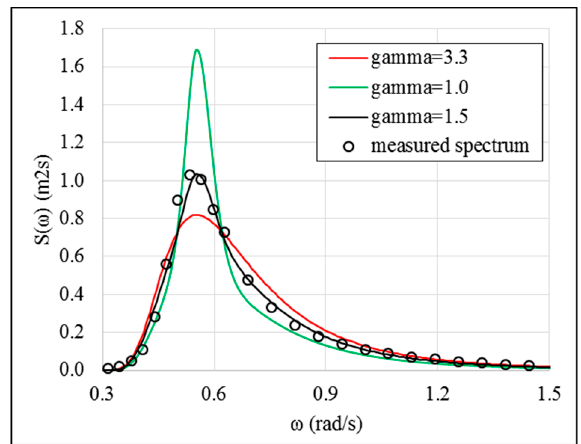
Figure 11. Measured spectrum (average) and the corresponding Bretschneider and JONSWAP spectra ( H m 0 = 2.25 m, T e = 9.75 s), T pc is calculated using Equation (8).